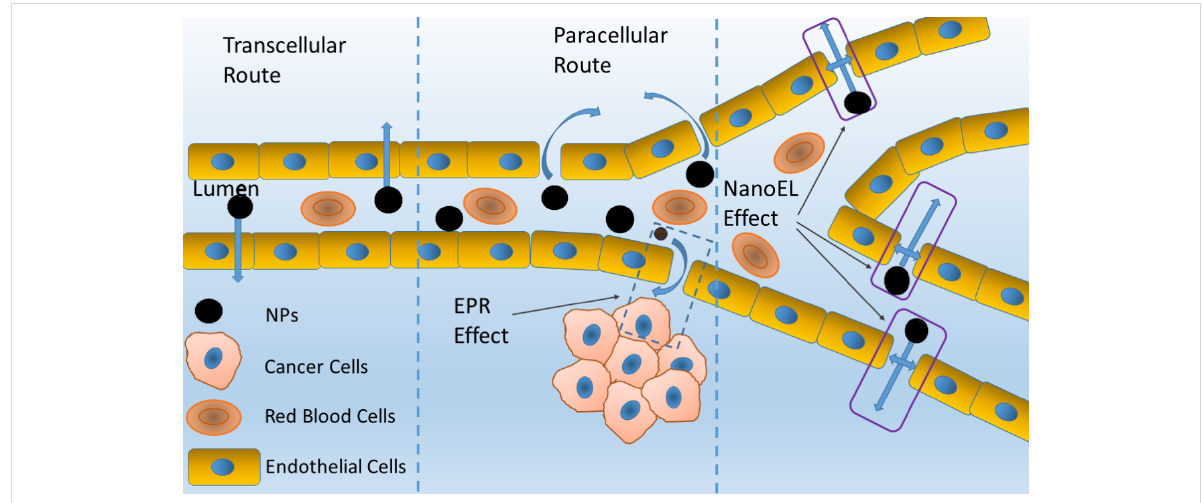
Figure 2: Two main routes to transport NPs across the endothelium, namely the transcellular route and the paracellular route. NanoEL: active trans- port mechanism of NPs across the endothelium that is unrelated to the transcellular pathway.